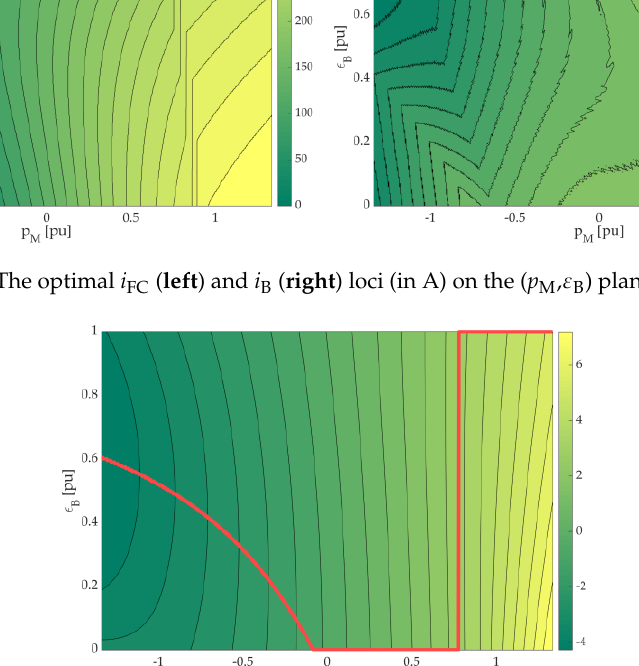
ε = B ) trajectory (in red, v B